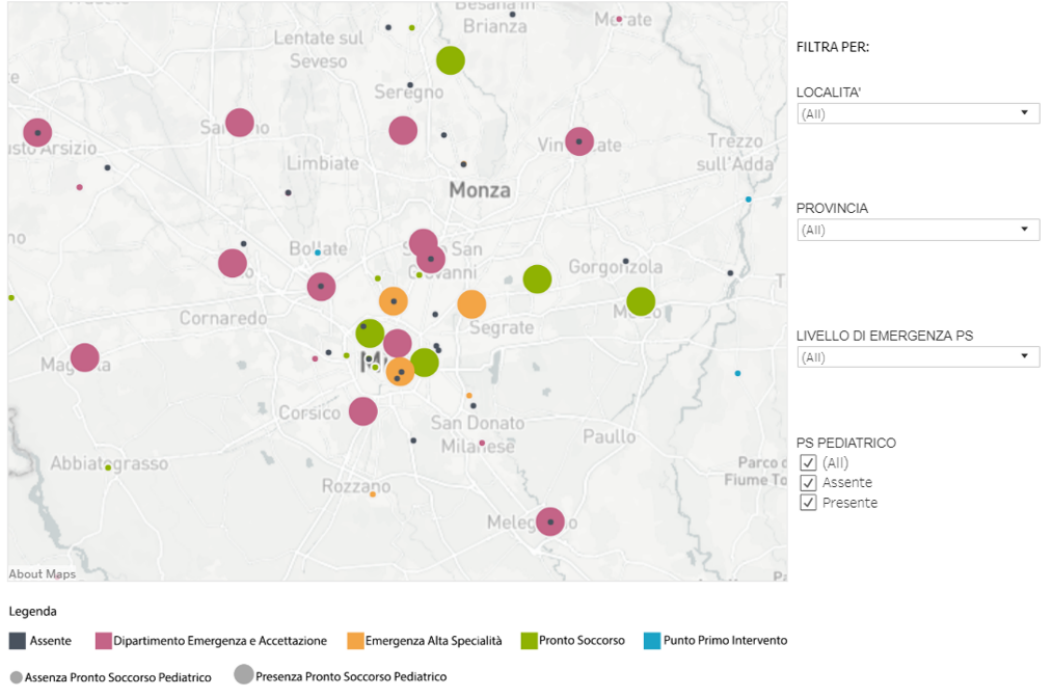
Figure 5. Map of hospitals (colored circles) centered in Northern Italy, in the Milan area, indicating whether they have an emergency room, the kind of emergency room they have, and whether they have a pediatric emergency room. (right) Filters allow for selection of city (“Localitá”), province (“Provincia”), emergency level (“Livello di emergenza PS”), and presence or absence of pediatric emergency room (“PS